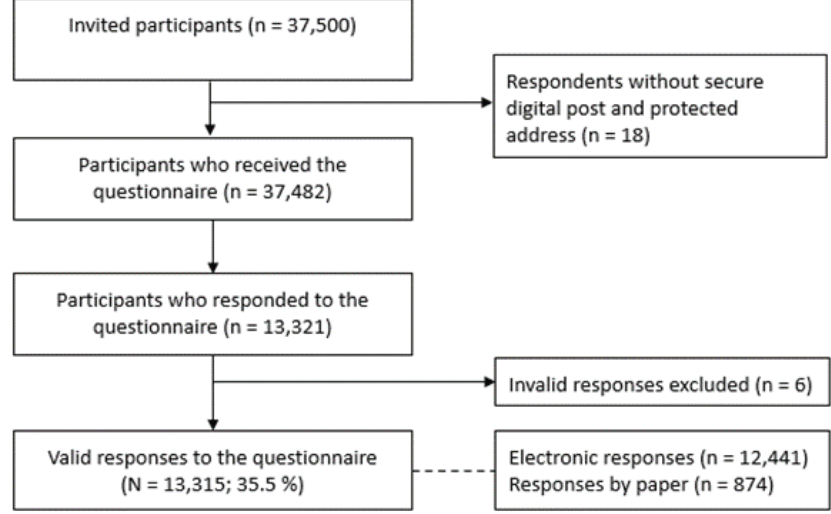
Figure 1. Flow diagram over participants in the §SMOKE study.